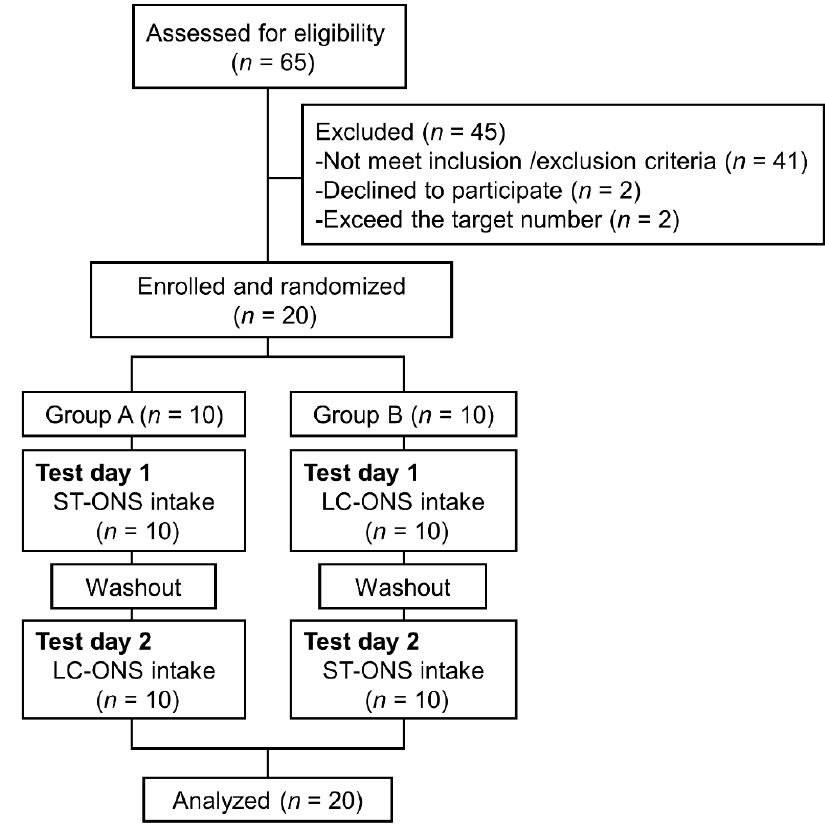
Figure 1. Flow chart of the study.